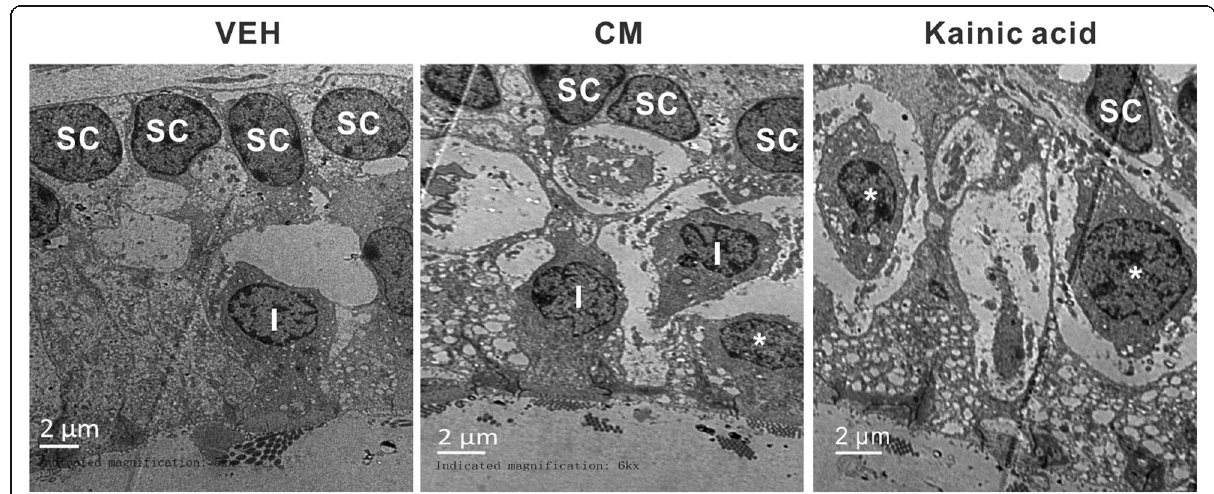
Fig. 2 Morphological evaluation of excitotoxic damages by electron microscopy. In vehicle tissue, type I hair cells (I) surrounded by calyx nerve endings and supporting cells (sc) were in order. In CM tissue, supporting cells (sc) were still in order, but type I hair cells (I) were separated by vacuoles. In injured inner ear, most hair cell type became undetermined (asterisk) and numerous swollen nerve terminals below hair cells were observed. Scale bars = 2 μ m, n = 3/